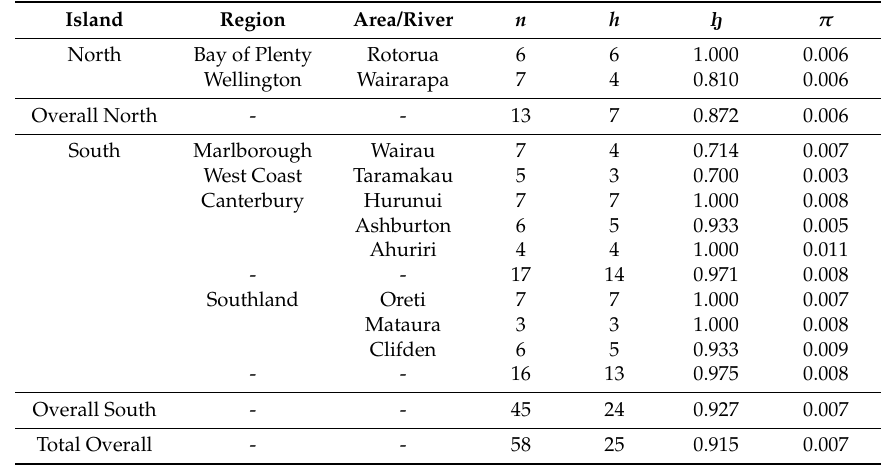
Figure 2. Median-joining haplotype network of black-billed gulls using 597 bp of mtDNA control region (first domain) sequences. Shared haplotypes are indicated by circles which are proportional to the number of individuals sharing that haplotype. Cross-hatches are indicative of the number of nucleotide differences between haplotypes. Colours show individual catchments. Table 1. Genetic variation at 597 bp of mtDNA control region (first domain) in New Zealand black-billed gull populations, calculated using only the individuals from the larger of the two main clades, shown in Figure 1, to reduce any potential bias caused by hybridisation with red-billed gulls (individuals in the smaller of the two main clades).